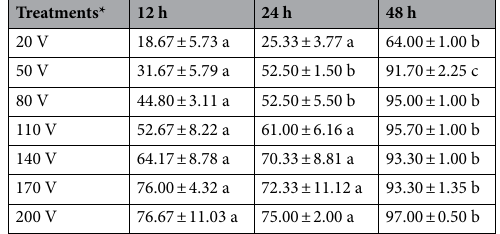
Table 1. The mortality rate (%) of germinated seeds after treating with DC electrophoresis bath under different voltage and processing times. *The different letters mean significant difference at 5% level.